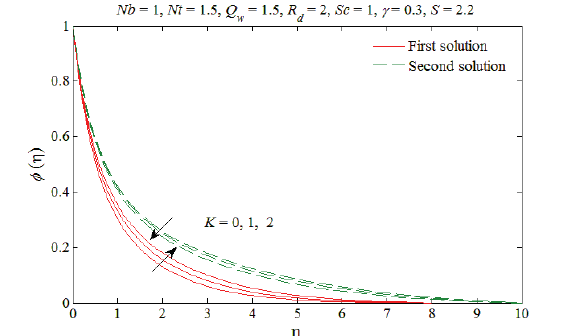
Fig. 3: The concentration profiles for different values of K .